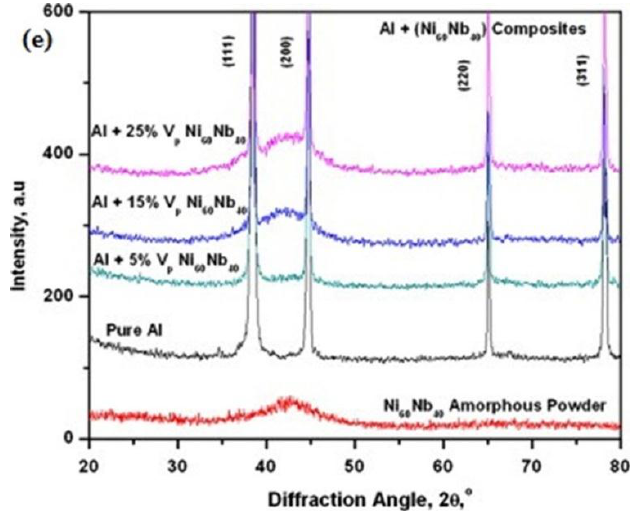
Figure 2. Results of microstructural ( a – d ) analyses conducted on Al-matrix composites reinforced with Ni 60 Nb 40 metallic glass powder, Results of X-ray diffraction analyses ( e ) conducted on Al-matrix composites reinforced with Ni 60 Nb 40 metallic glass powder (reprinted from Jayalakshmi et al . 2014 [7], with permission from ©